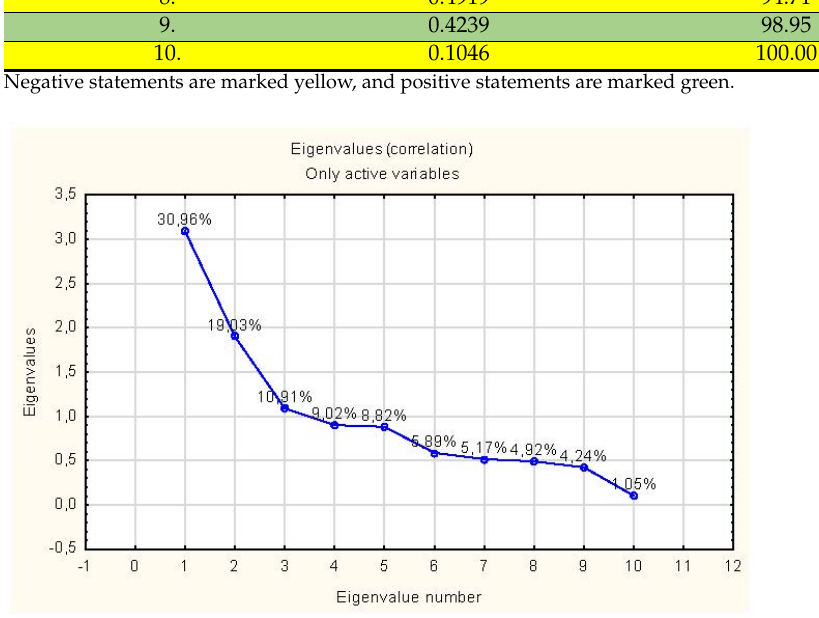
Table 2. Equity and cumulative percentage of variability.